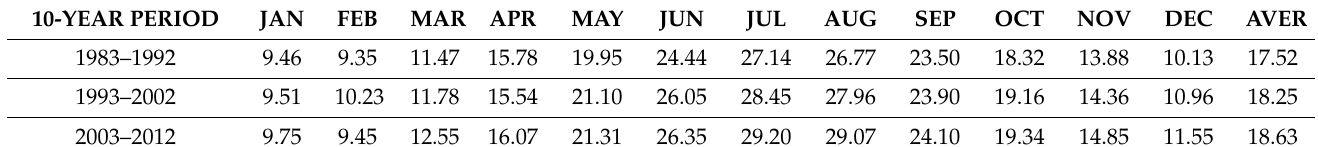
Table 1. Mean monthly and average annual air temperatures of the three time periods, Athens.